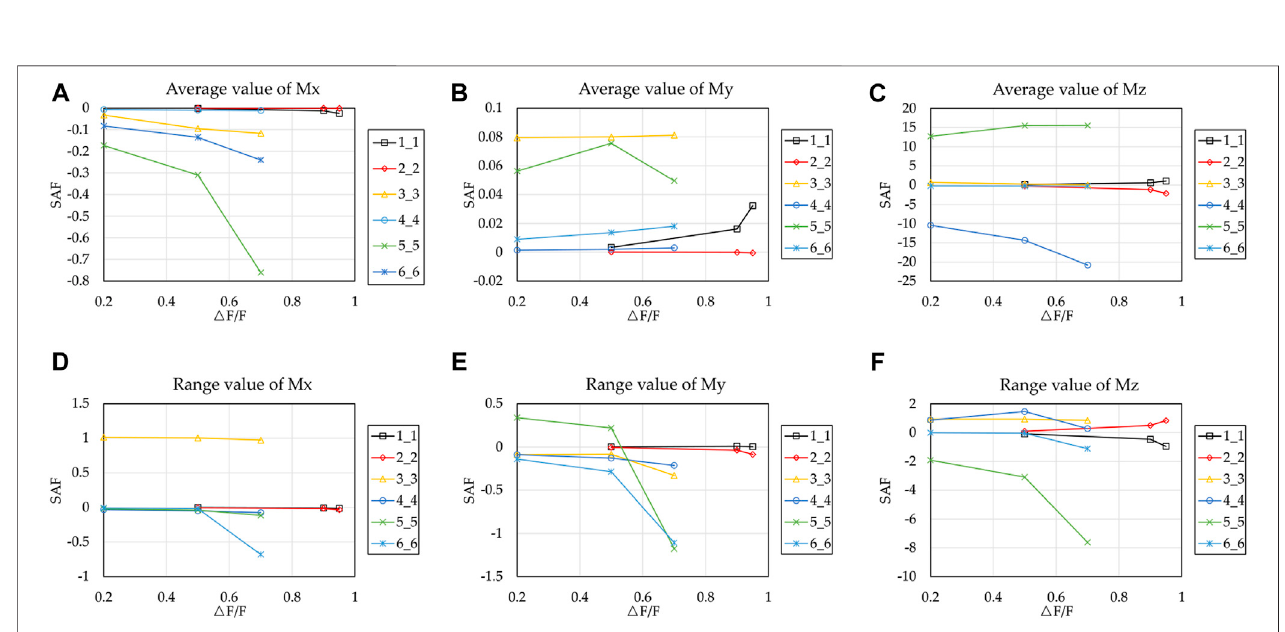
FIGURE 5 | Sensitivity of main diagonal stiffness to blade root moment.